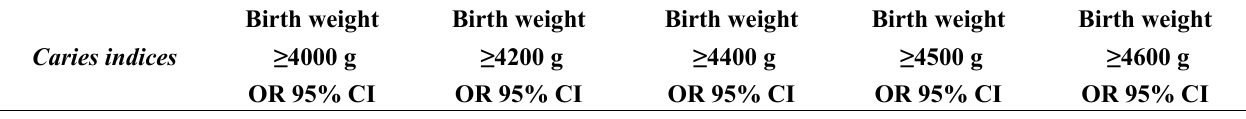
Table 5. Logistic regression analysis with the magnitude of high birth weight as the exposure and caries experience at 19 years of age and caries increment between 13 and 19 years of age as an